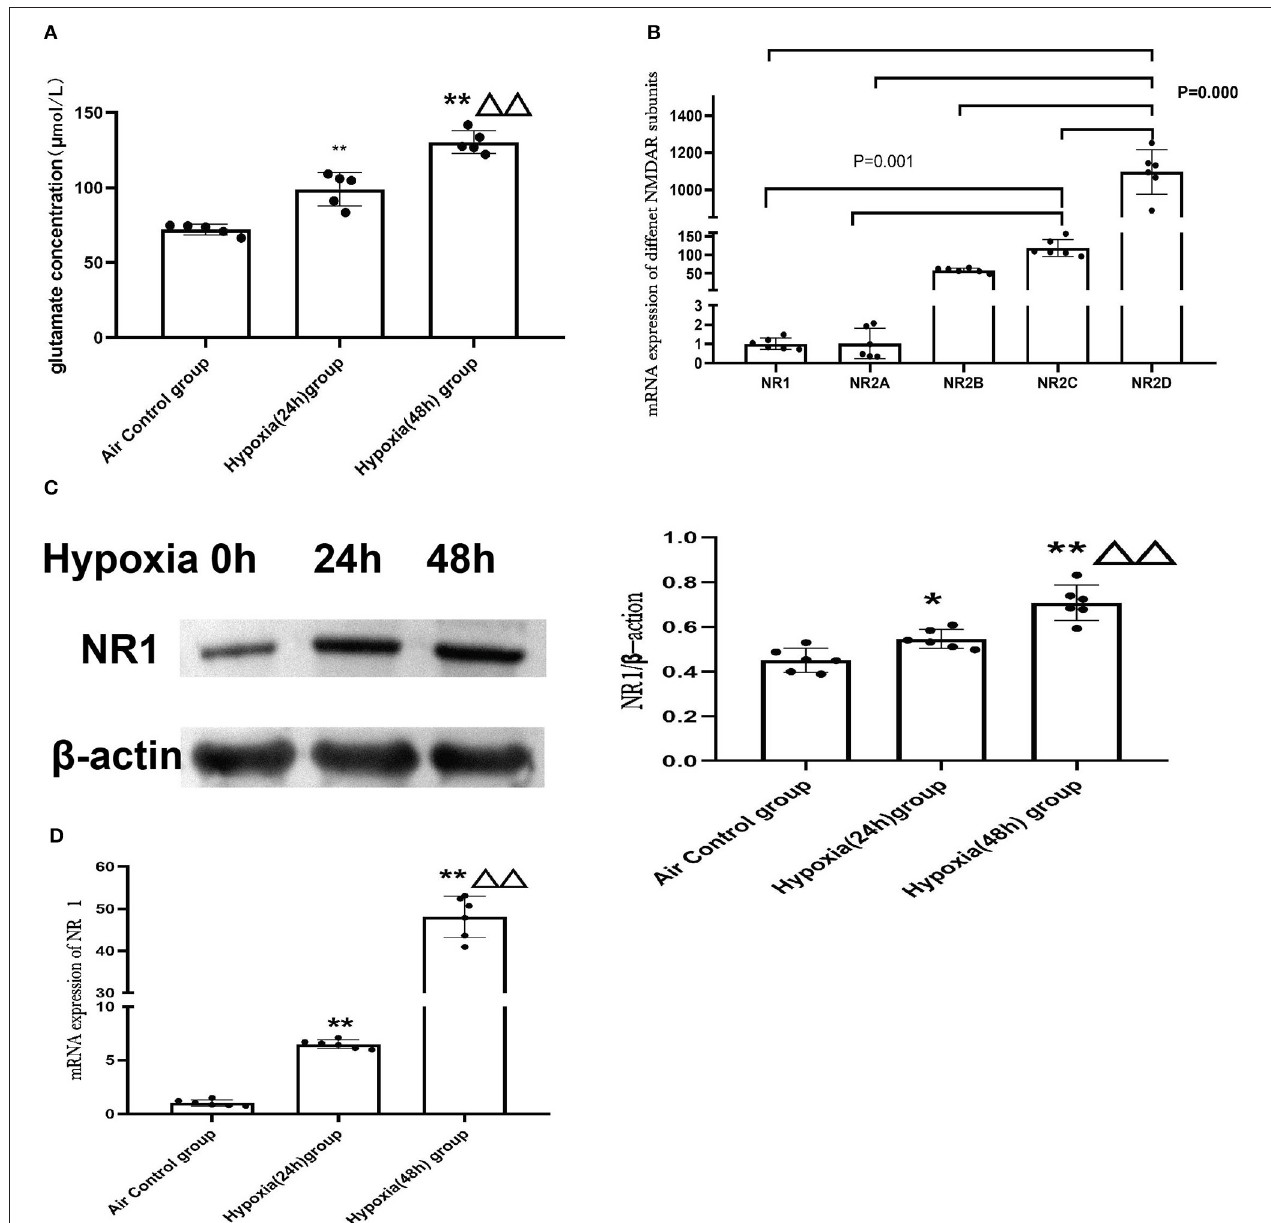
FIGURE 6 | Hypoxia induced elevation of glutamate concentrations in H9c2 cell supernatant and increased the expression of NMDAR. (A) Glutamate concentration in the H9C2 cell supernatant ( N = 5); (B) NMDAR subunit expression in H9c2 cells ( N = 6); (C) The representative western blot images of NR1 after hypoxia exposure ( C -left) and semi-quantified level of NR1 protein expression ( C -right); (D) mRNA expression of NR1. Compared with the air control group: * P < 0.05, ** P < 0.01; compared with the Hypoxia 24 h group: △ P < 0.05, △△ P < 0.01. All data are presented as mean ±